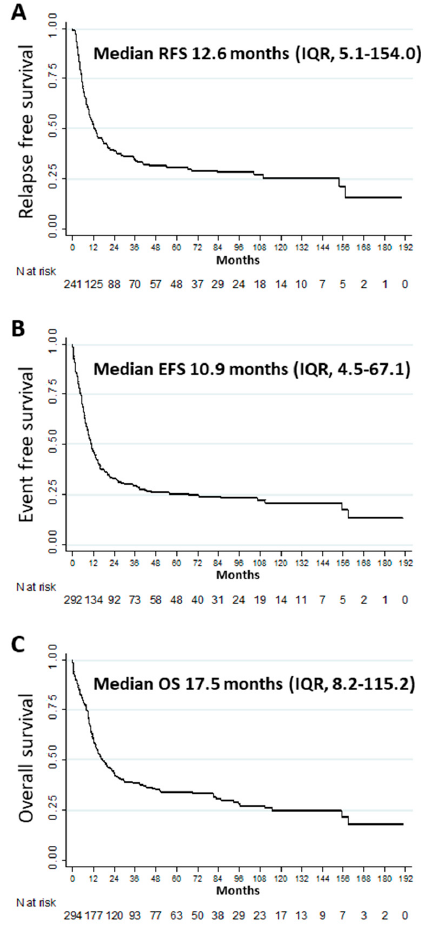
Figure 1. Outcomes among patients with newly diagnosed FLT3 -ITD acute myeloid leukemia: ( A ) relapse-free survival ( n = 241), ( B ) event-free survival ( n = 292), ( C ) overall survival ( n = 294). Table 2. Outcome of FLT3 -ITD AML patients in first line or R/R situation. Outcome